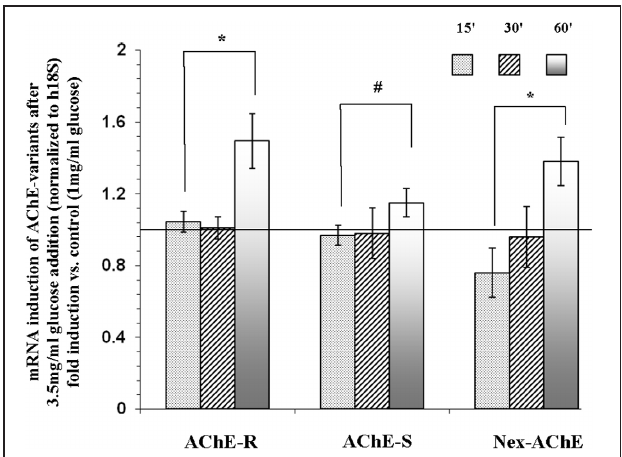
FIGURE 5 | mRNA expression of N-extended AChE, AChE-S, and AChE-R isoforms following treatment of Y79 cells with glucose for 1h. Y79 cells were pre-treated for 16–24h in starvation medium (1% FBS and 1mg/ml of glucose) and then with 3.5mg/ml glucose for different time intervals. Total RNA was extracted and cDNA was prepared for real-time PCR procedure as described under Materials and Methods. Results are presented as fold of control cells cultured in starvation media. Values are means ± SEM, ( N = 4). ∗ p < 0 . 05, # p = 0 . 12.